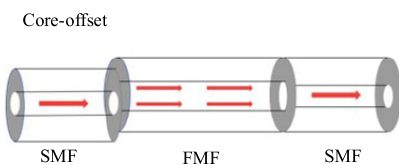
Fig. 1 Schematic diagram of the proposed SMF-FMF-SMF fiber